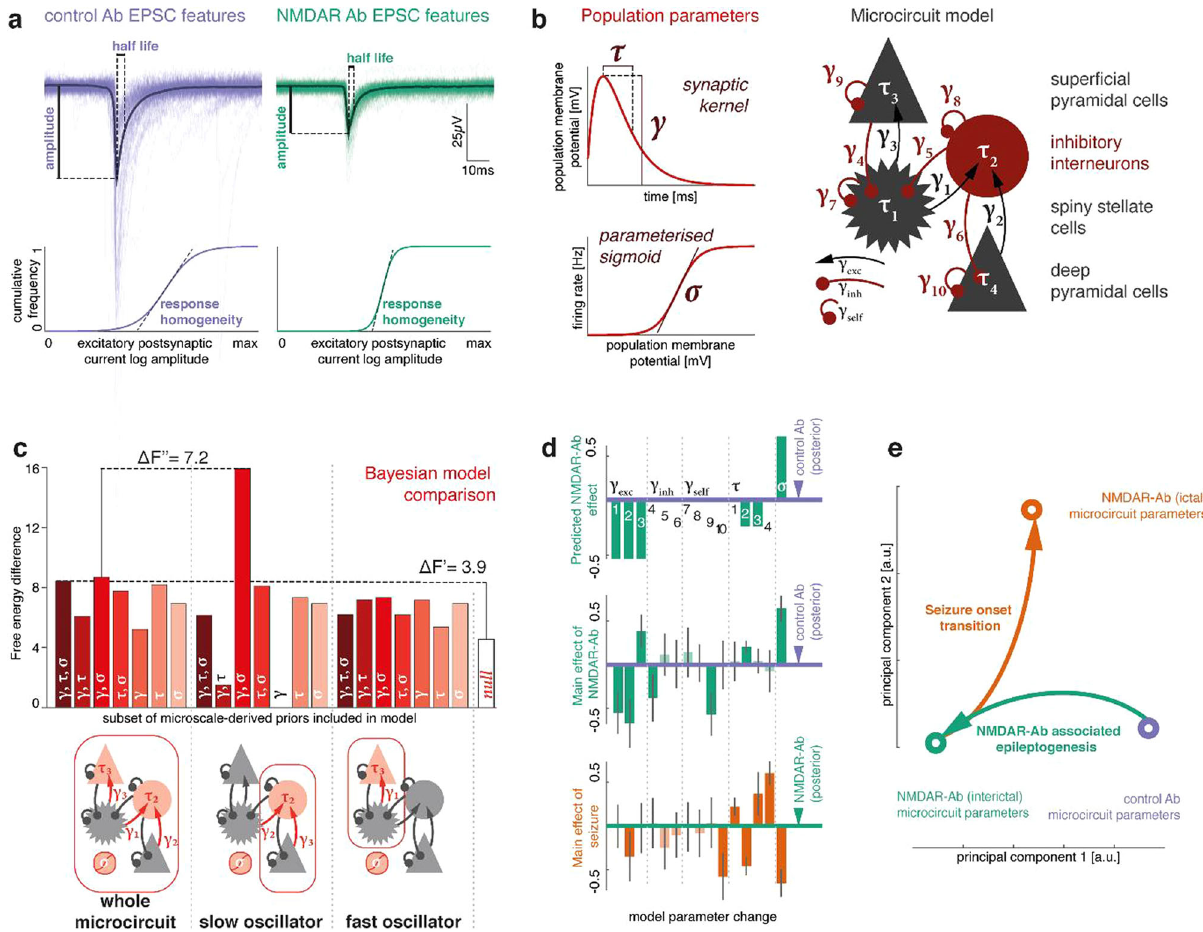
Fig. 4 In vitro microscale disruptions of excitatory neurotransmission explain NMDAR antibody-associated in vivo neurophysiological changes. a In vitro recordings of sEPSCs were used to quantify differences between control antibody and NMDAR antibody related neurotransmission, including half-life and amplitude of EPSCs. We also estimated EPSC homogeneity by fi tting a sigmoid curve to the cumulative frequency of EPSC amplitudes, where the slope at the midpoint increases with more homogeneous EPSC amplitude distribution. b Microscale data features map onto population parameters in a canonical microcircuit model consisting of two layered neuronal oscillator pairs with recurrent excitation-inhibition coupling. Key synaptic parameters of this model are population synaptic response amplitude, time constant and response sigmoid, which are affected by EPSC amplitude, time constant, and amplitude distribution, respectively. Using the dynamic causal modelling framework, we fi t a single such microcircuit to local fi eld potential recordings in control Ab and NMDAR antibody exposed mice. c Bayesian model comparison is shown for inverted models of NMDAR antibody (interictal) local fi eld potential dynamics where subsets of the excitatory synaptic parameters were informed by priors derived from microscale recordings. There is decisive evidence that the full model, where all parameters had microscale-informed priors, provides a more parsimonious explanation for the data than the model without predictive priors (BF ~ Δ F ’ = 3.9). Of all tested models, the model containing predictive priors only for amplitude ( γ ) and population variance ( σ ), and only for the slow neuronal oscillator populations (inhibitory interneurons and deep pyramidal cells) performed best (BF ~ Δ F ’ = 3.9) with a posterior probability of >95% in the given model space. d Parameter differences between conditions are shown for control vs. interictal NMDAR antibody-associated dynamics (predicted NMDAR-Ab effect; main effect of NMDAR-Ab: estimated in the winning model), and seizure vs. interictal NMDAR antibody dynamics (main effect of seizure: estimated). Error bars indicate a Bayesian 95% credible interval. Darker shading parameters where the estimated difference exceeds the credible interval. e A principal component decomposition of the full parameter set across three states (control antibody, NMDAR antibody (interictal), and NMDAR antibody (seizure)) shows separability of the main effects of antibody (with most of the difference along the fi rst principal component) and seizure onset (with most of the difference along the second principal